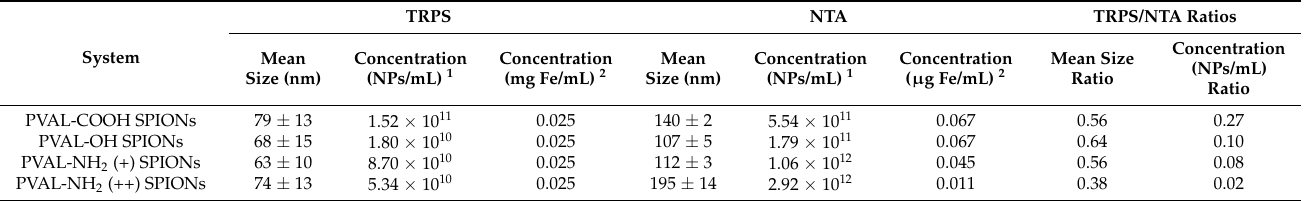
Table 4. Particle size and concentration obtained by the NTA and TRPS. All values are averaged from 3 different replicates. The ratio TRPS/NTA calculated for the size and concentration illustrate the difference between the techniques (last 2 columns).